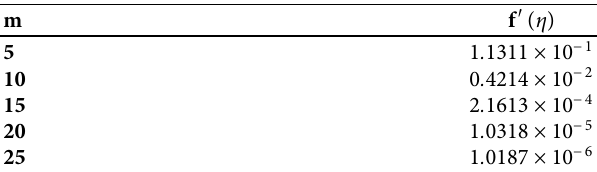
Table 2: The convergence of the flow problem for velocity equation in x direction, Gul et al. [51].